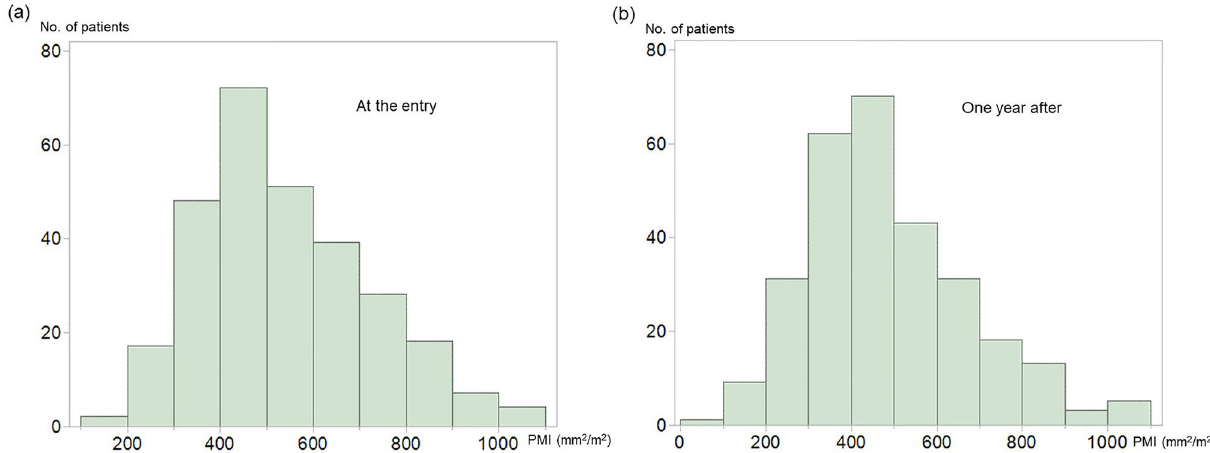
Figure 1. (a) Histogram of the psoas muscle index at entry. (b) Histogram of the psoas muscle index 1 year after entry. As shown in the two histograms, the patients in this study experienced 9.5% of muscle mass loss in 1 year. Statistical analyses were performed using the JMP Pro 15.0.0 (3903308).